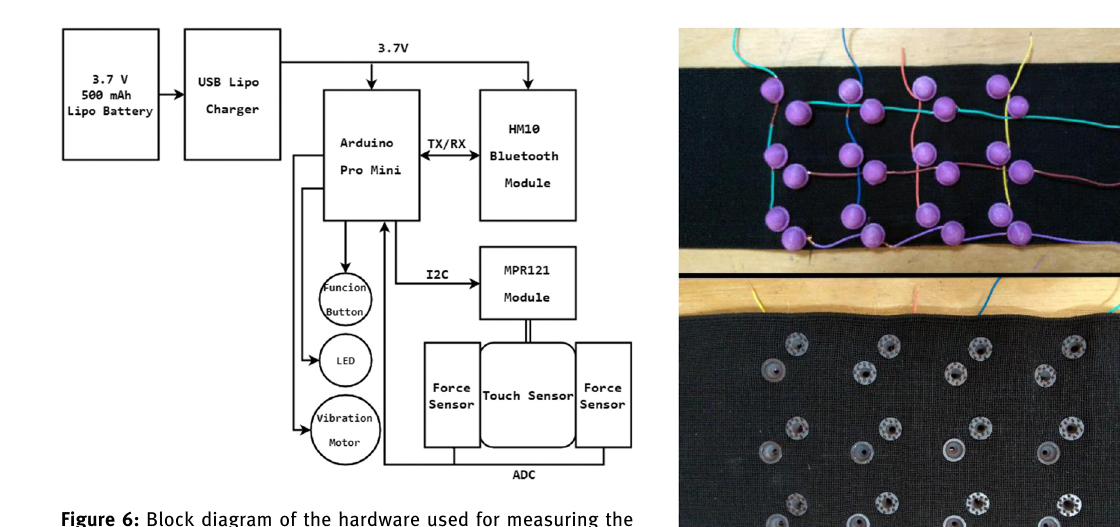
Figure 6: Block diagram of the hardware used for measuring the touch sensor and transmitting its information.